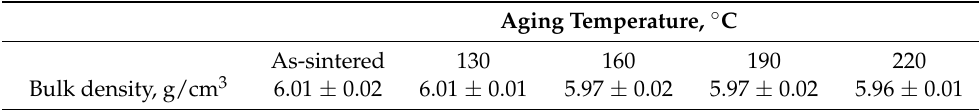
Table 2. The bulk density of 3Y-TZP specimens aged for 10 h in air after sintering for 20 h at 1550 ◦ C.